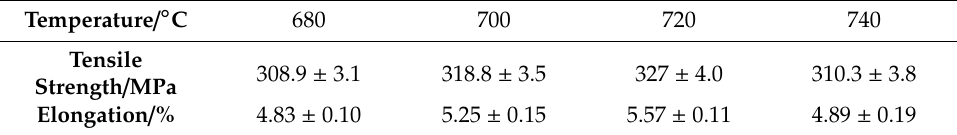
Table 4. Mechanical properties of vacuum counter-pressure casting aluminum alloy with UST.